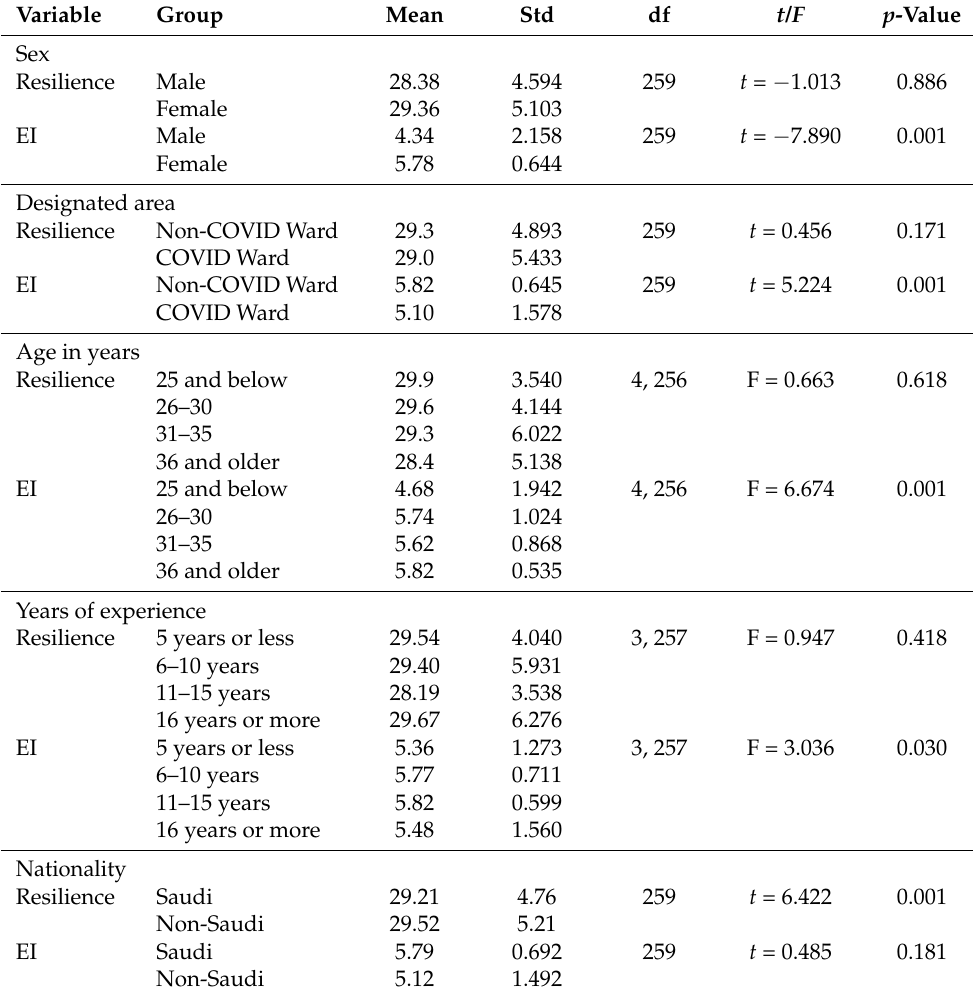
Table 2. Differences between demographic characteristics, resilience, and emotional